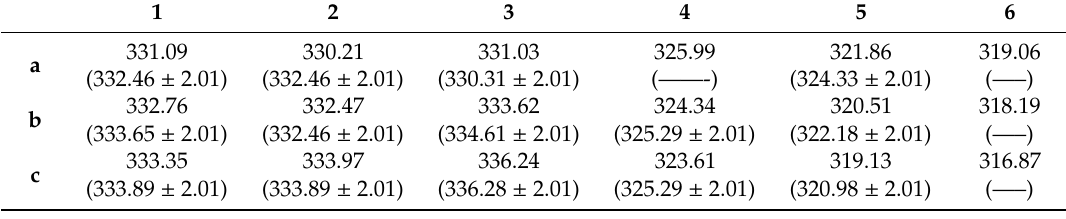
Table 1. Absolute gas phase acidities for 1a – 6c . The values are reported in kcal/mol. Δ acid G ° = G °(anion) + G°(H + ) − G °(acid). The experimental values are given in parentheses and were obtained from http://webbook.nist.gov/chemistry/ [31].